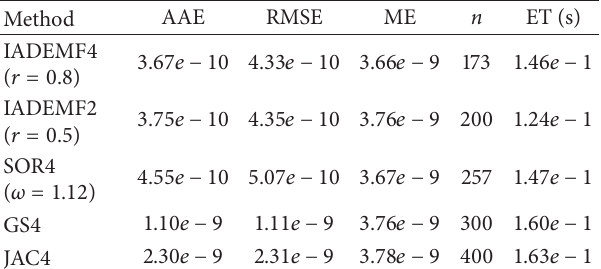
Table 6: Experiment 1. 𝑚 = 7000 , 𝜆 = 0.5 , Δ𝑥 = 1.43 × 10 −4 , Δ𝑡 = 1.02 × 10 −8 , 𝑡 = 5.10 × 10 −7 , and 𝜀 = 10 −10 .